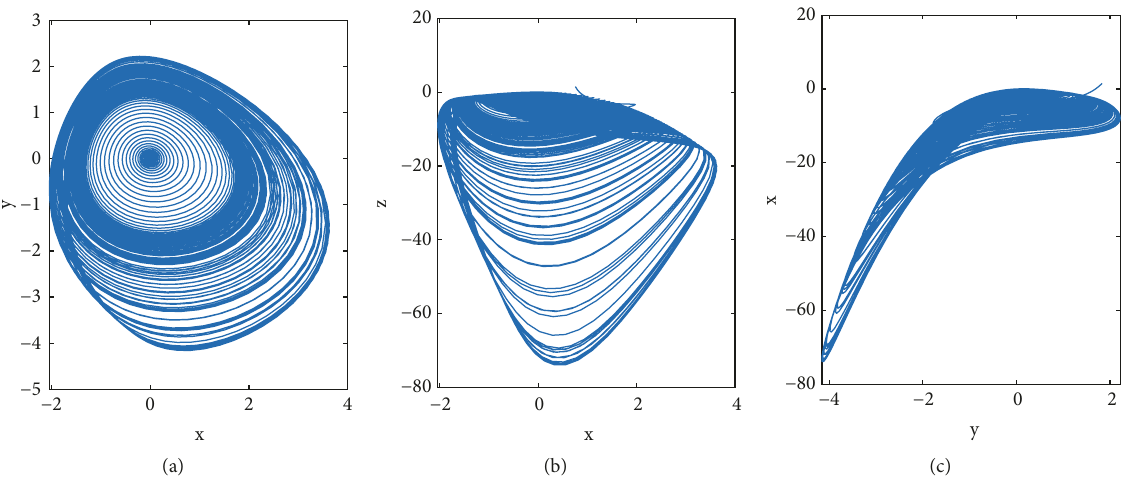
Figure 2: Two-dimensional attractor diagram of system (1): (a) 2D ( 𝑥 − 𝑦 ), (b) 2D ( 𝑥 − 𝑧 ), (c) 2D ( 𝑦 − 𝑧 ).